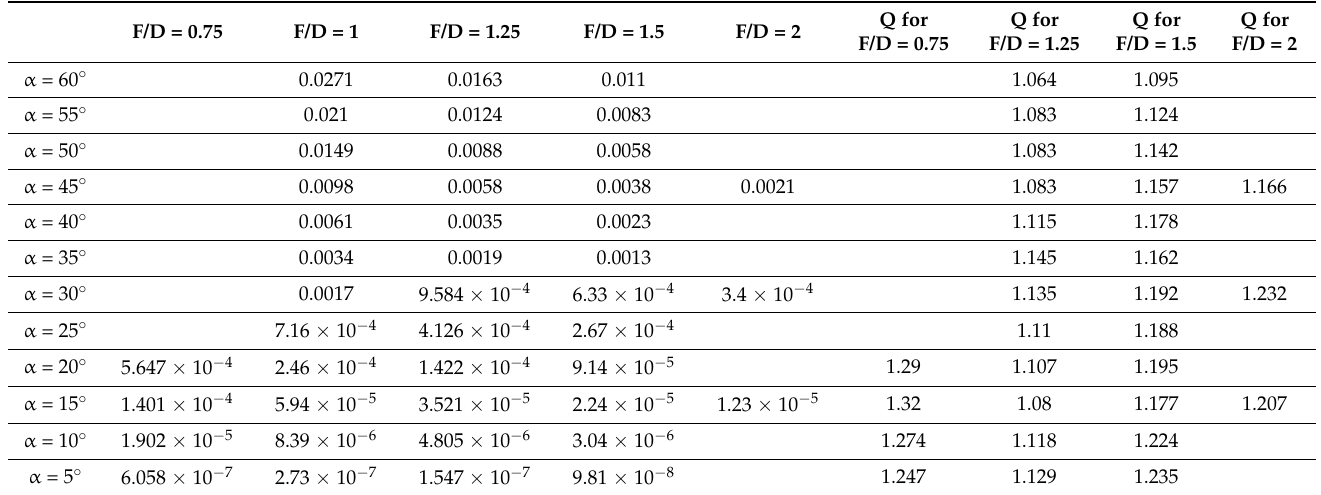
Table 2. Comparison between maximum aberrations of lenses with 1, 2, ∼ 5 foci. F/D = 1, M = 1; D = Table 1. Max aberrations [in λ ] vs max scanning angle for different F/D (to have them in degrees a 360 factor is required). M = zoom = 1; D = 30 λ .